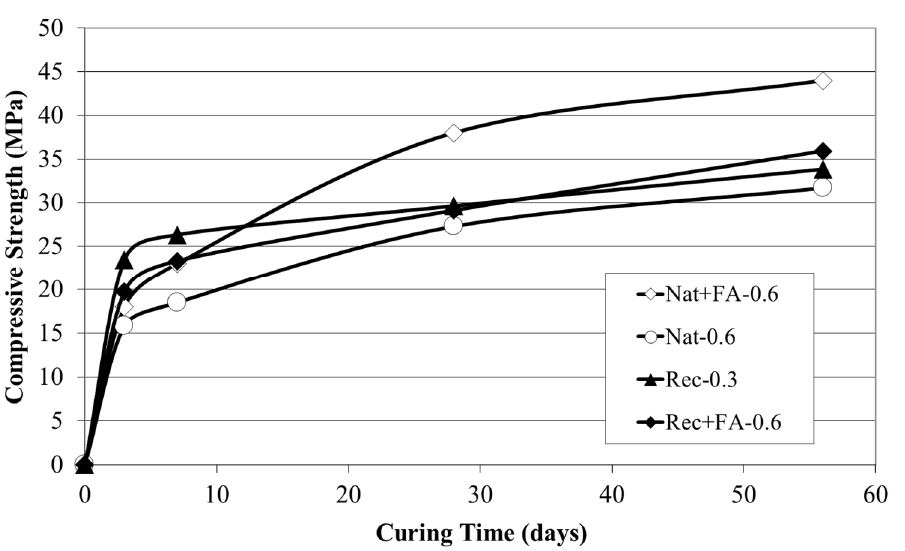
Figure 2. Compressive strength vs. curing time.